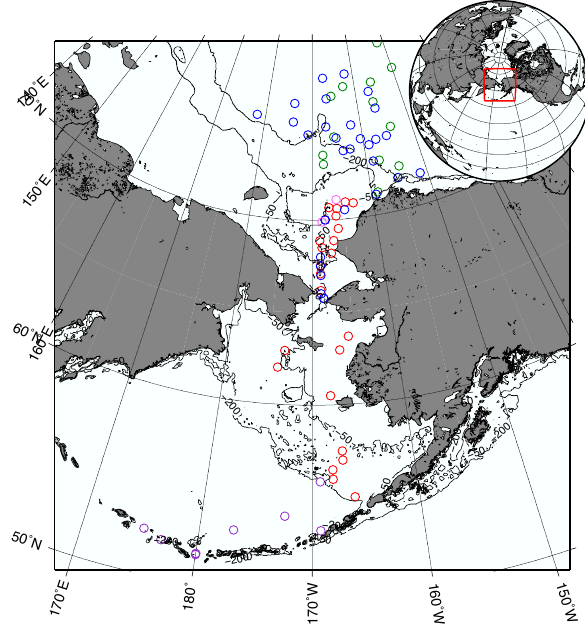
Fig. 1. Location of 75 stations that in situ data were obtained for this Fig. 1 . Location of 75 stations that in situ data were obtained for this study. Data for SDM 3 study. Data for SDM development were sampled during the OS180 development were sampled during the OS180 (red circles) and those for SDM validation were 4 (red circles) and those for SDM validation were sampled during sampled during the OS190 (pink circles), KH09-4 (purple circles), MR09-03 (green circles) 5 the OS190 (pink circles), KH09-4 (purple circles) and MR10-05 (blue circles). Bathymetry contours indicated are 50- and 200-m and MR10-05 (blue circles). Bathymetry contours indicated are 50- and 200-m intervals. 6 intervals.